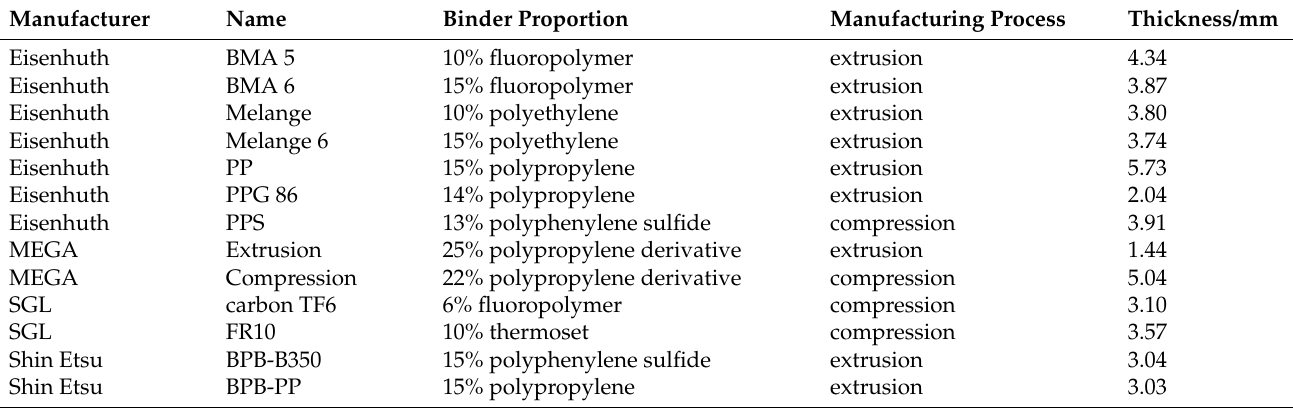
Table 2. List of carbon–polymer composite bipolar plates used in the study, together with their producers, commercial name and main characteristics.